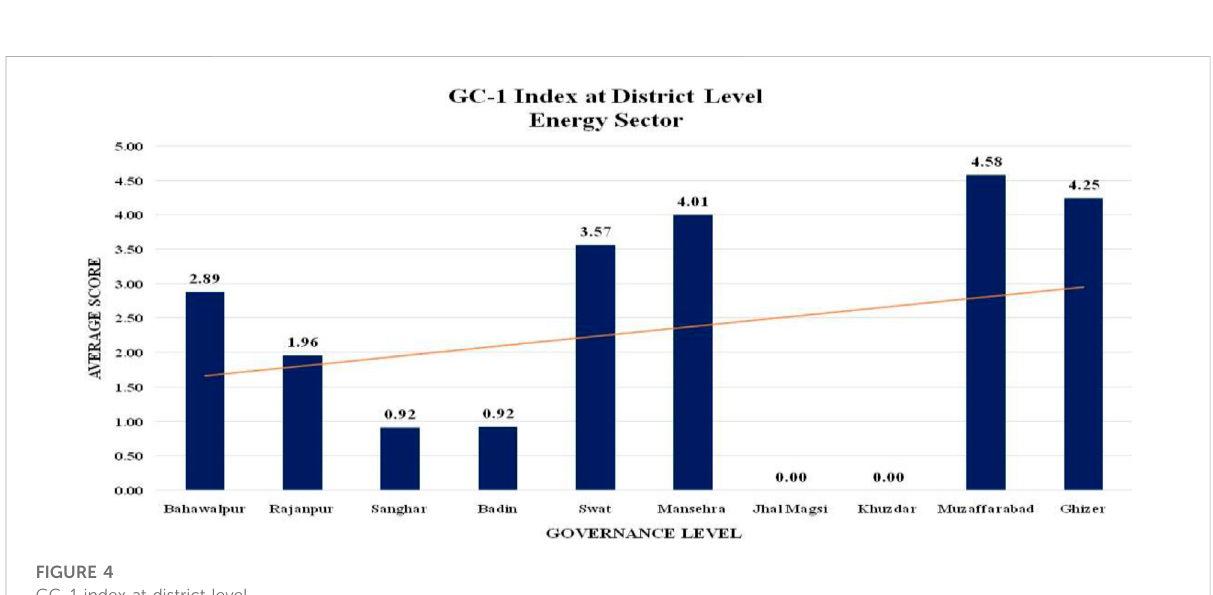
FIGURE 4 GC-1 index at district